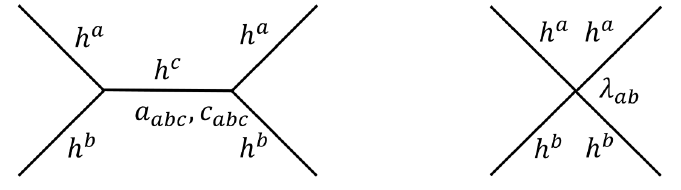
Figure 12 . Feynman diagrams for elastic scattering h a h b → h a h b ( a 6 = b ) in the pesudo-linear theory. The left diagram contributes a and c to the positivity bound and the right one abc a,b,c contributes λ to the ab